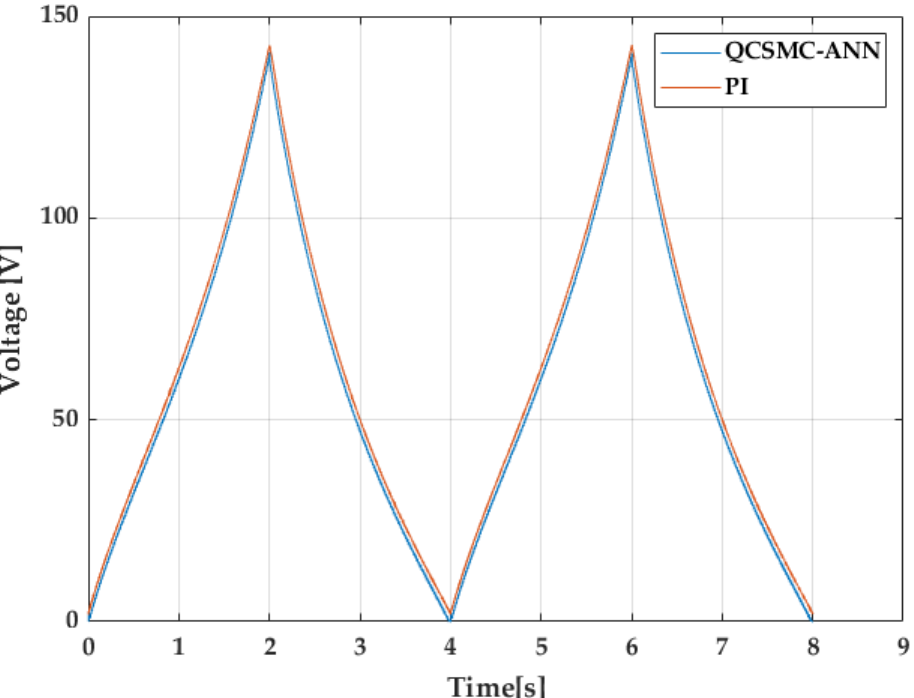
Figure 7. The control signal in 2 cycles of a triangular